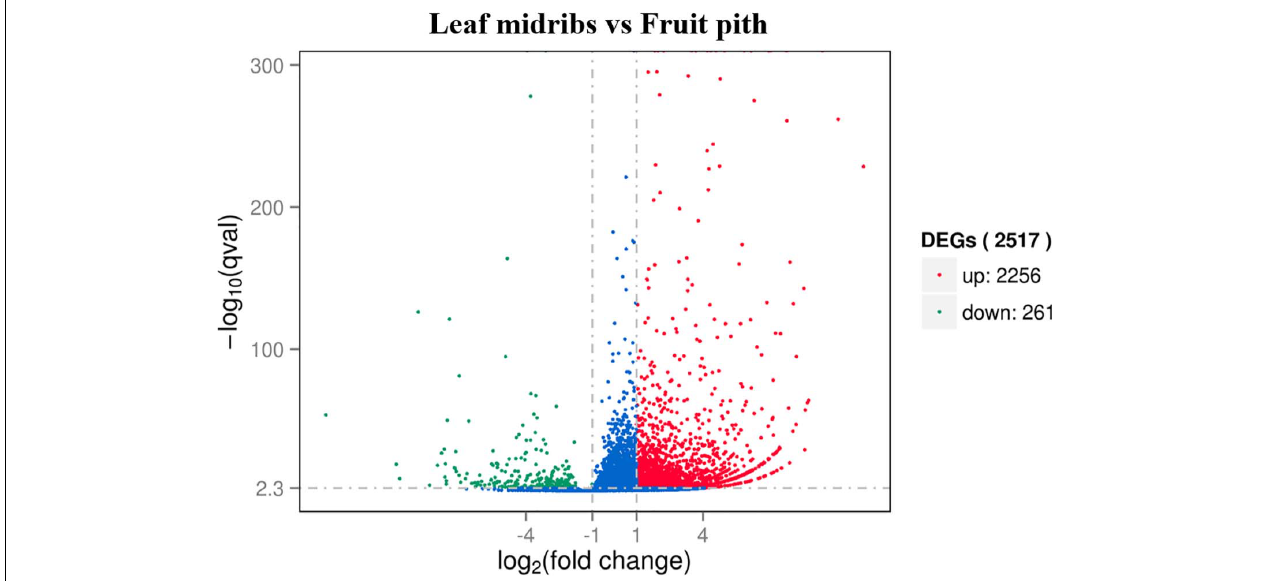
FIGURE 4 | Volcano plot representation of differential expression analysis of host genes in “ Candidatus Liberibacter asiaticus” (CLas)–infected leaf midribs and CLas-infected fruit pith. Red and green points mark the genes with significantly increased or decreased expression, respectively, in leaf midribs compared with fruit pith samples (FDR < 0.01). The blue points mark the genes with no significantly different expression. The x -axis represents log2 fold changes in expression, and the y -axis represents statistically significant difference in gene expression.